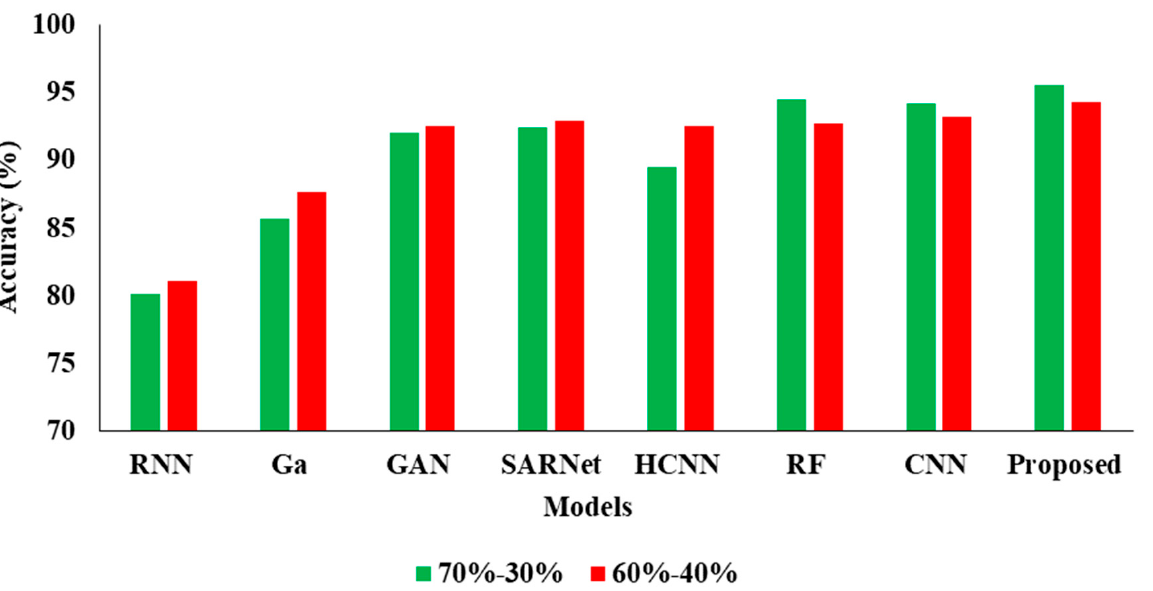
Table 4. Comparative Analysis of Proposed Model with existing techniques.